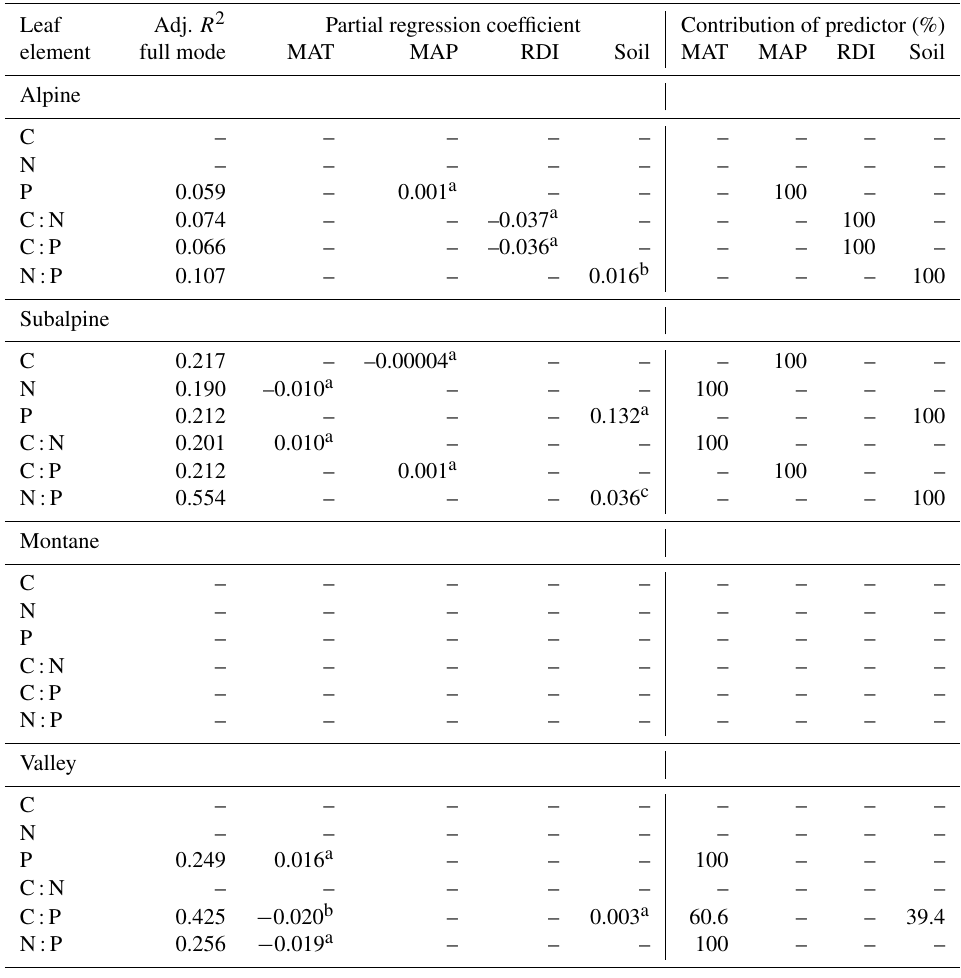
Table A4. Model summary for the stepwise multiple regression (SMR) of leaf element concentrations of different ecosystem types on the climatic and soil variables (MAT, MAP, RDI, soil element and ratio). Leaf Adj. R 2 Partial regression coefficient Contribution of predictor (%) element